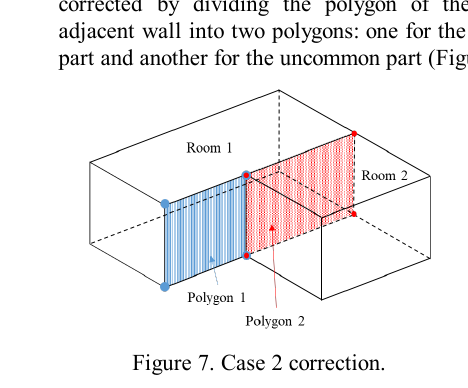
Figure 7. Case 2 correction.